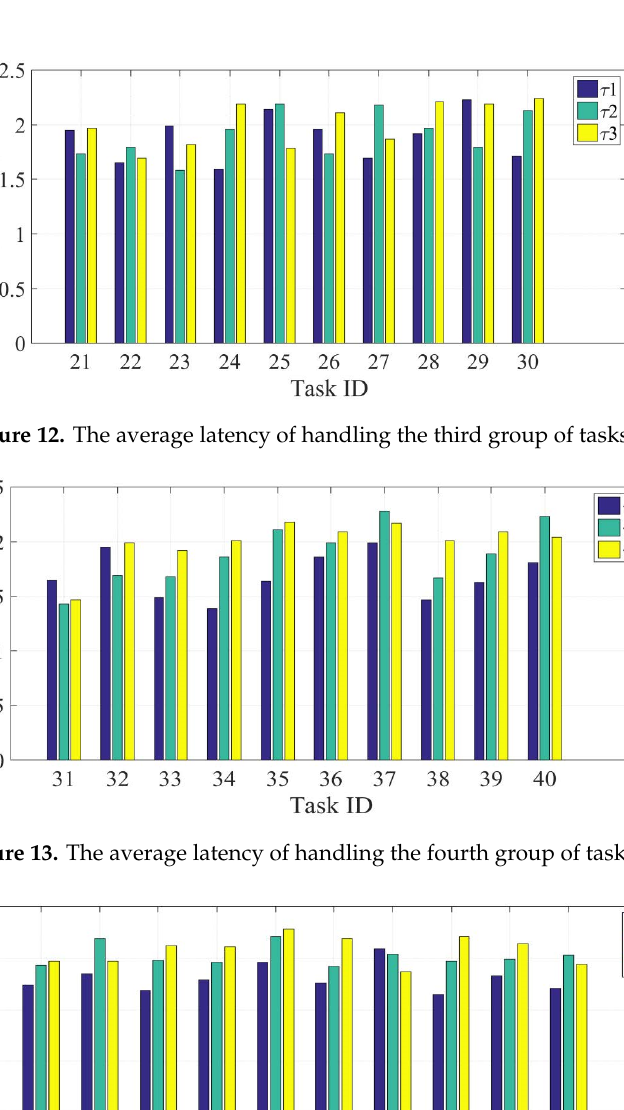
Figure 11. The average latency of handling the second group of tasks.